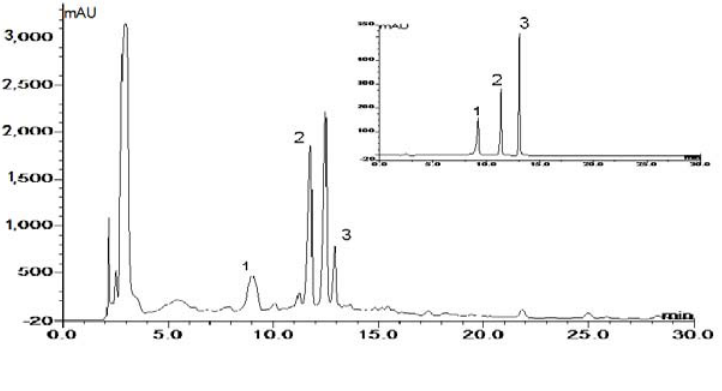
Figure 2. Examples of chromatograms of standards and sample: ( 1 ) myricetin; ( 2 ) quercetin; ( 3 ) kaempferol, the inset shows the chromatogram of three standard substances.